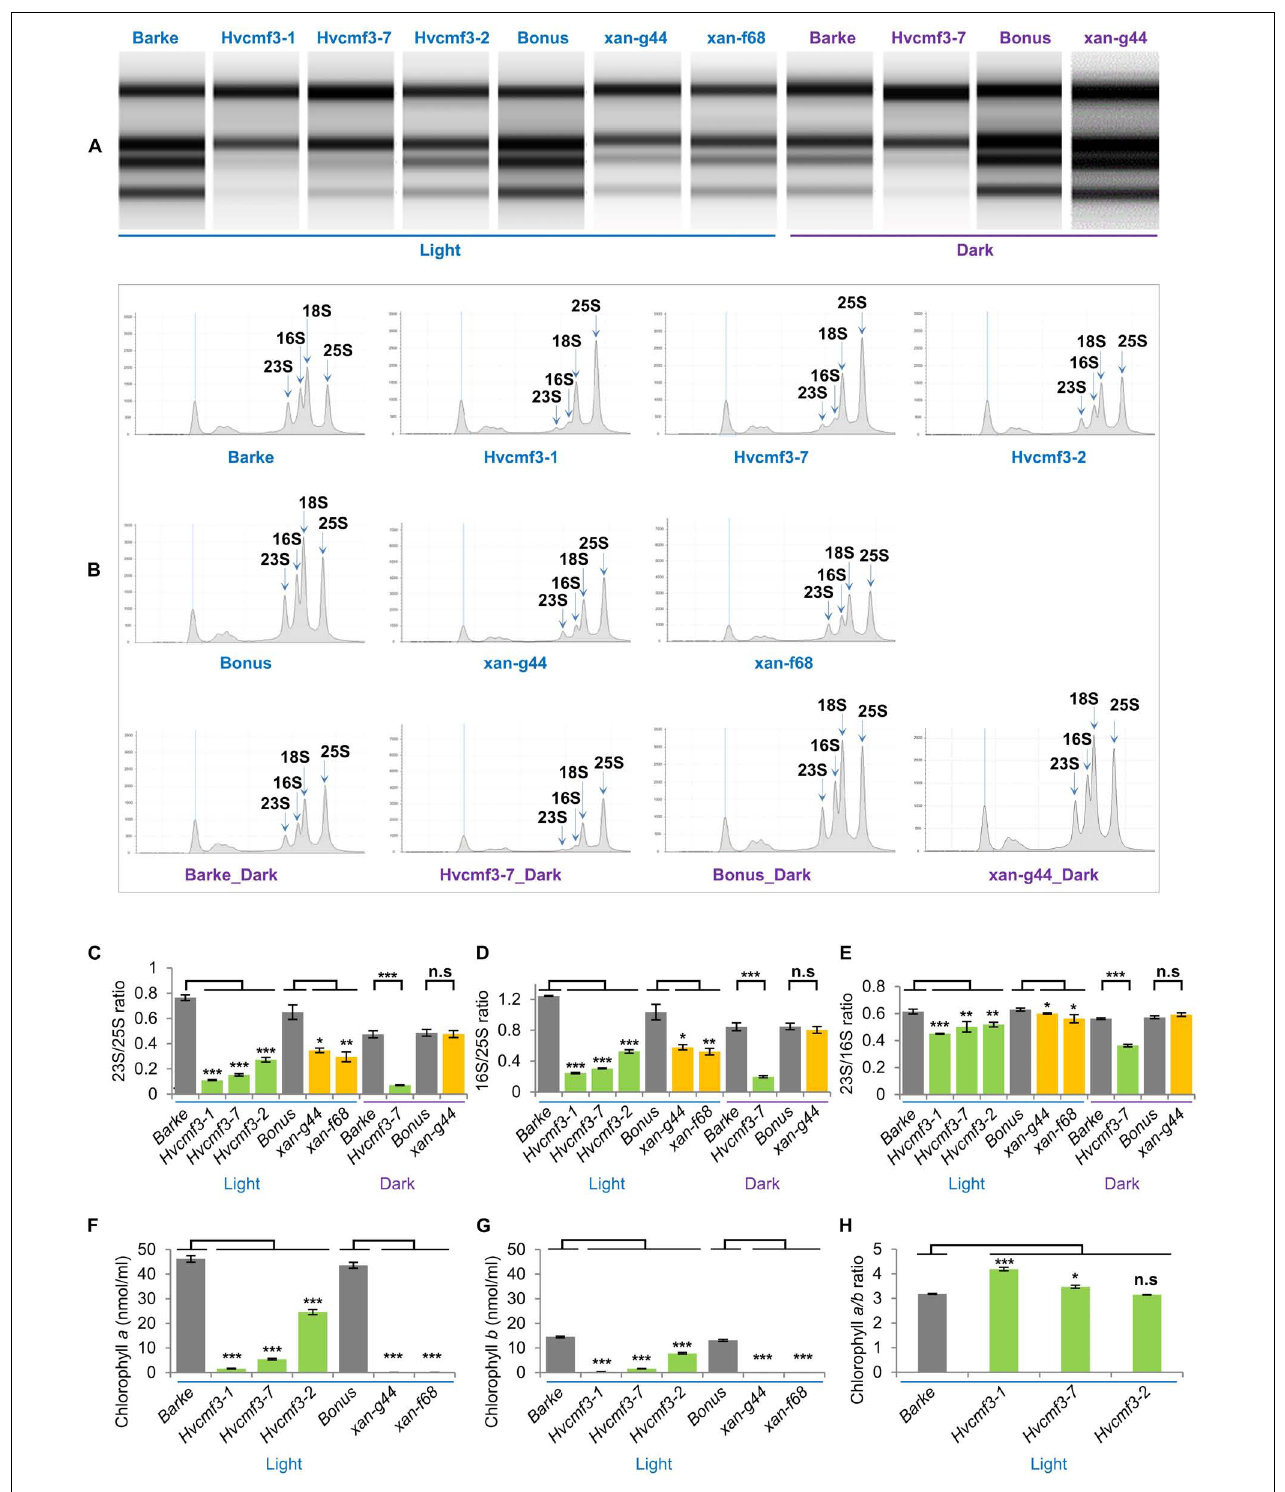
FIGURE 5 | rRNA analysis and chlorophyll content measurement. (A) Separation of cytosolic and plastid rRNAs using the Agilent high sensitivity RNA ScreenTape assay. (B) Analysis of rRNA from wild type, Hvcmf3 mutants and xantha mutants using an Agilent Tapestation 4200. (C,D) Determination of plastid-to-cytosolic rRNA ratios. (C) 23S/25S; (D) 16S/25S. (E) Ratio of the plastid 23S rRNA to the plastid 16S rRNA. (F–H) Analysis of chlorophyll contents and ratio between chlorophyll a and chlorophyll b . Results are presented as means ± SE. t-test significant level: * p < 0.05; ** p < 0.01; *** p < 0.001, n.s, not significant. Three plants per genotype were analyzed. The level of significance is given for paired comparisons of either genotype within the two categories. The exact p -values are provided in Supplementary Dataset 3 ).